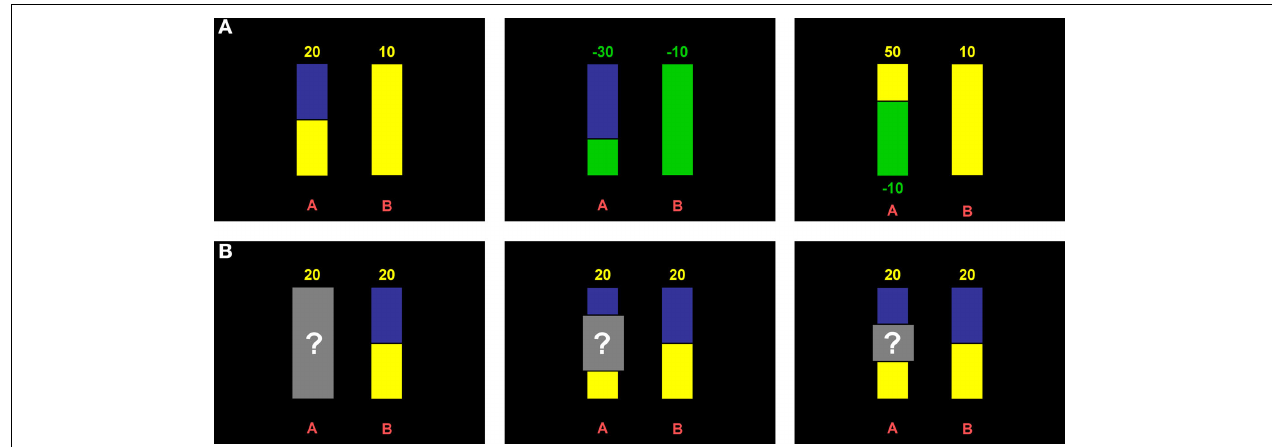
FIGURE 1 | Behavioral paradigm. (A) Example displays of risk trials. Colors indicatethedomains(yellow:gains;green:losses;blue:neutral).Amountsthat canbewonor lostaredepicted above thebars, orincaseofthemixeddomain, above and below, respectively. Height of the colored part of the bars indicates